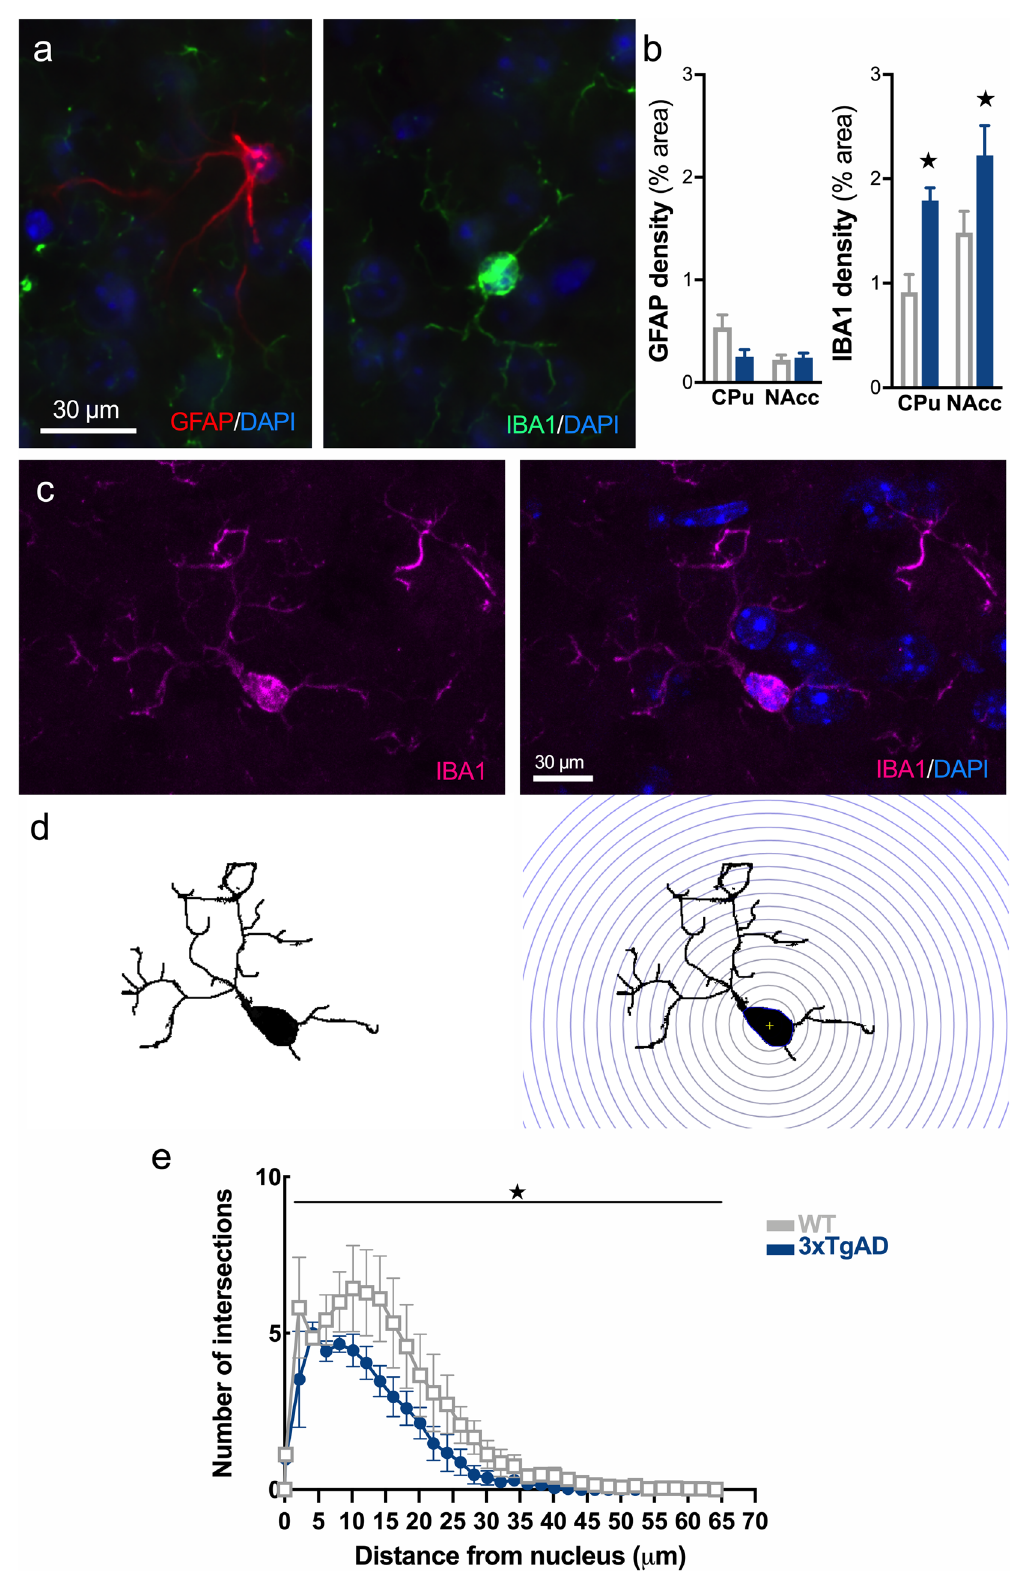
Figure 2. Early microglial reactivity in the striatum of 3xTg-AD mice. (a) Example of immunofluorescence for DAPI (blue), GFAP (red) and IBA1 (green) in the striatum. (b) Quantification of the area occupied by GFAP and IBA1 staining. (c) Representative example of IBA1 + microglial cells (magenta) and DAPI (blue) showing soma co-staining. (d) Procedure for isolating a microglial cell and applying the Sholl filter in concentric circles from the center of the soma to the end of ramifications. (e) Quantification of intersection number in WT (grey, open circles) and 3xTg-AD (blue, triangles) mice. p <